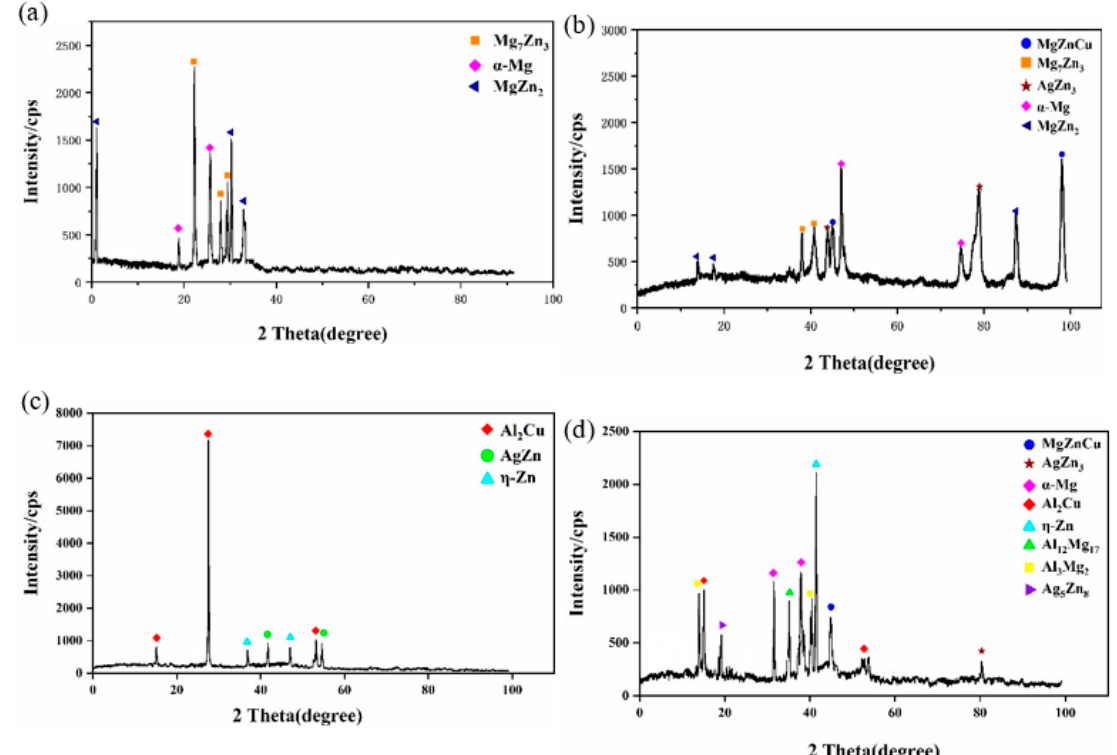
Figure 6. XRD analysis of the fracture path at 410, 440, and 460 °C. ( a ) 410 °C, 10 s; ( b ) 440 °C, 10 s; ( c ) 460 °C, 10 s; and ( d ) 460 °C, 15 s.